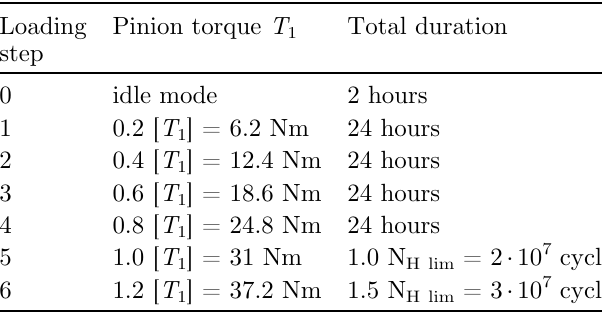
Table 8. Experimental multi-step procedure.